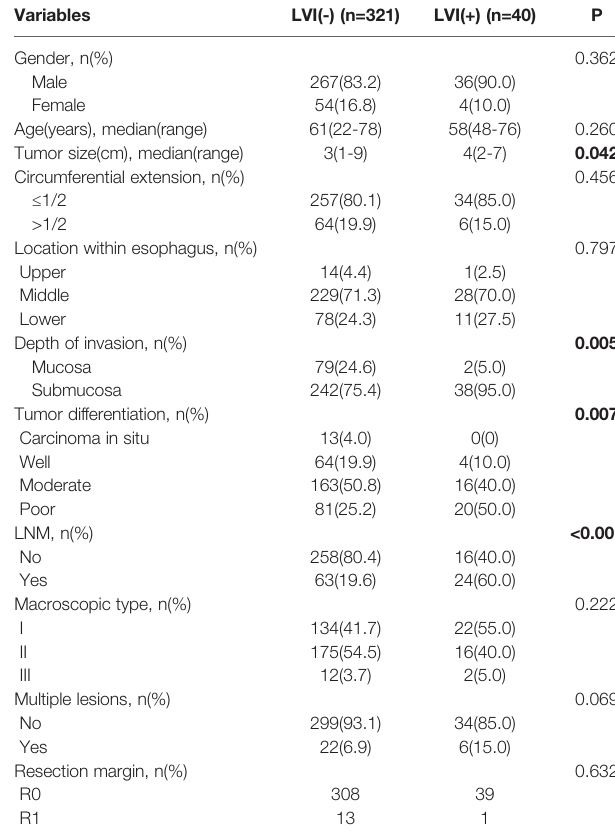
training set. Variables